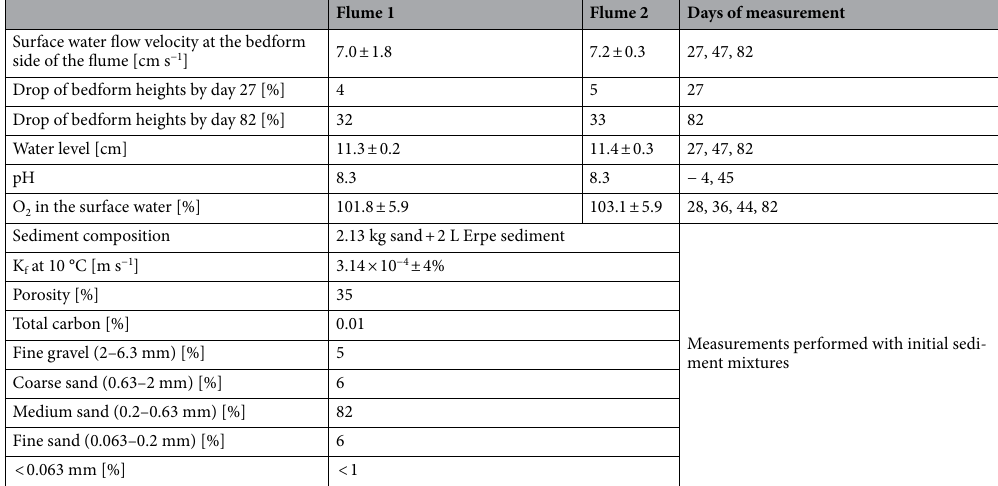
Flume 1 Flume 2 Days of